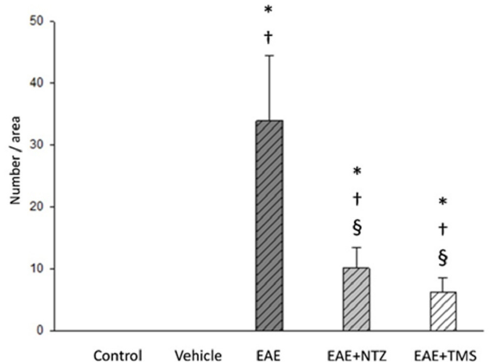
Figure 7. Number of muscle fibers with cytoarchitectural lesions per area in soleus muscle fibers at day 36. Values are means ±SD. There were no lesions detected in control and vehicle groups. * Significantly different (s.d.) from control group; † s.d. from vehicle group; § s.d. from EAE group ( n = 7 per group).